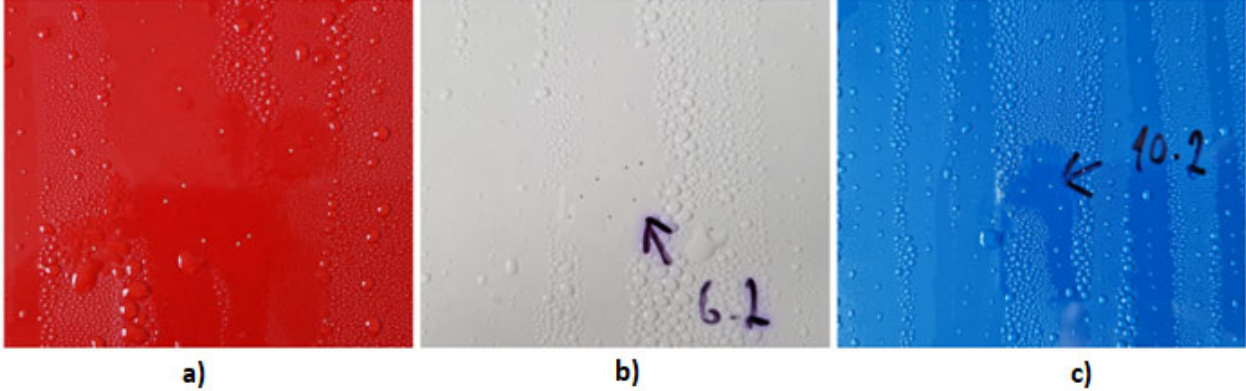
Figure 13. Hydrophobicity on non ‐ metallic samplesa ( a – c ).